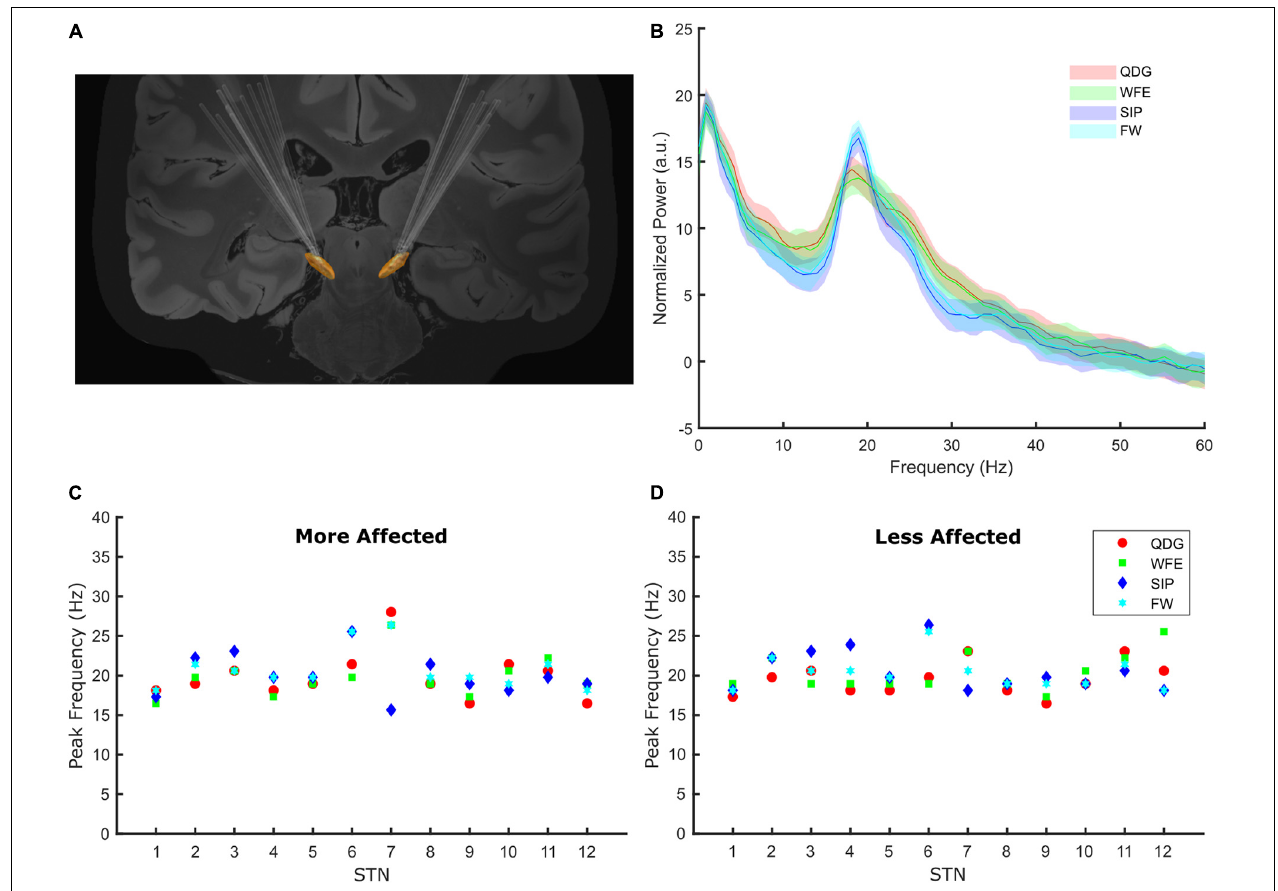
FIGURE 3 | (A) The lead placements for all participants for the left and right STNs. (B) The normalized grand average power spectral density plots for the four tasks. The power spectra were normalized to the average power in 45–63 Hz. The grand average PSD for each task was generated using the averaged data across all STNs during 30 s of movement. (C,D) The beta frequency peaks for each task by participant in the more and less affected